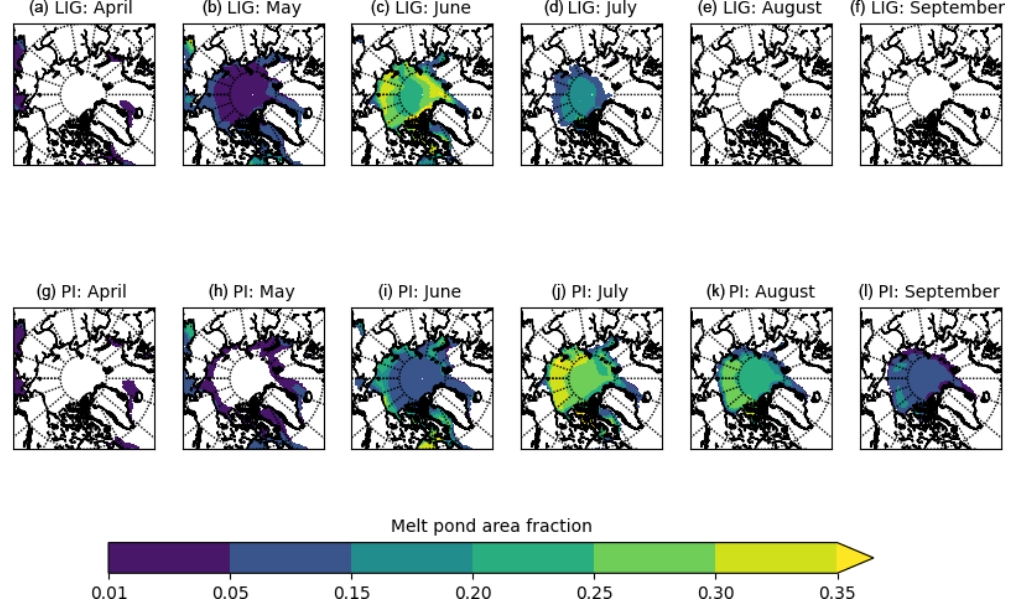
Figure 9. Melt pond fraction. Monthly simulated melt pond fraction of the grid cell for LIG and PI. The 200-year mean over the Northern Hemisphere for each month from April–September is shown, computed as the time average from monthly model